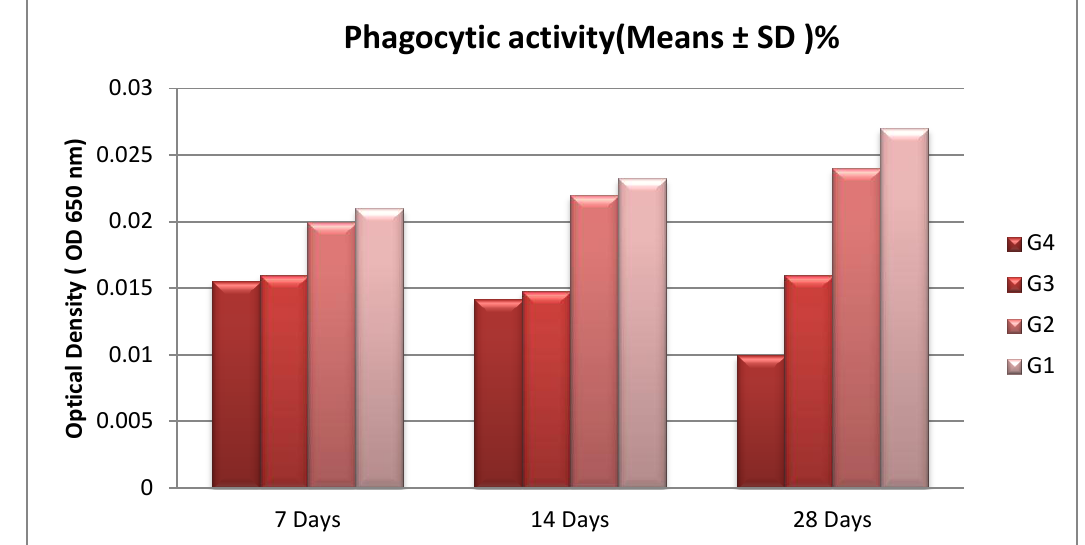
Figure -1: Percentage carbon particles in the blood circulation1 of treated group as compared to non treated control groups. Means ± SD (n=6)